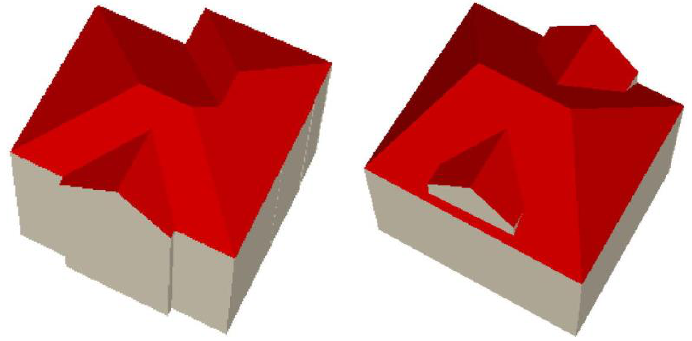
Figure 16. Incorrect and ambiguous matching of different buildings from the same topological graph.